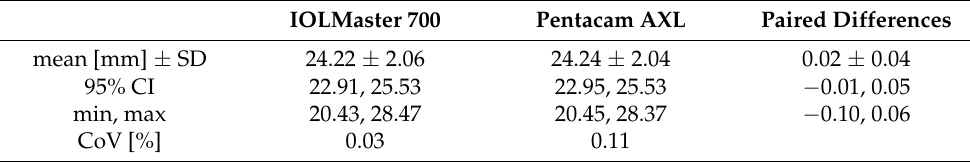
Table 1. Axial length measurements of the verification group using two optical